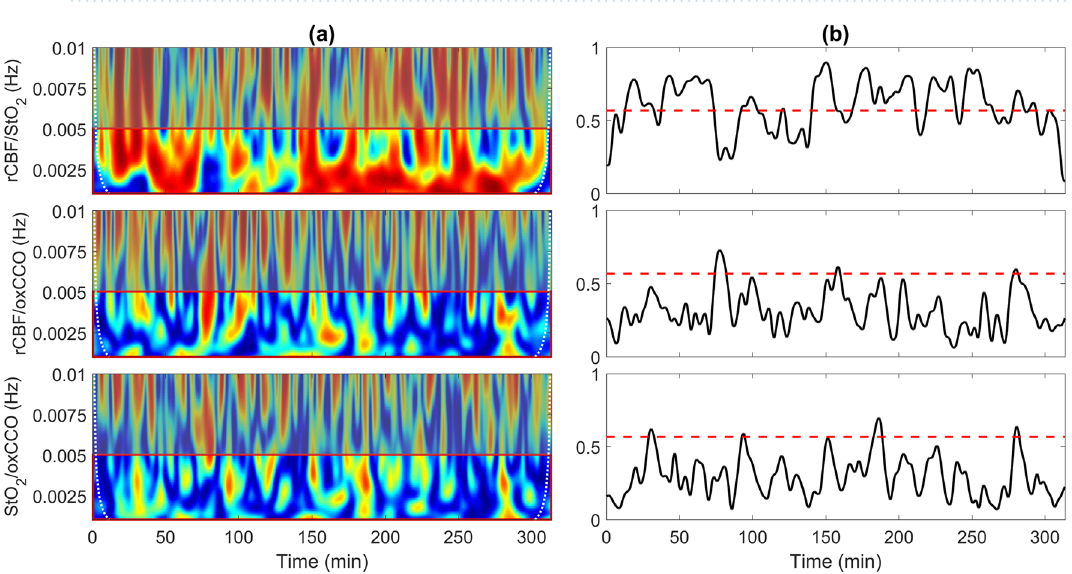
Figure 2. ( a ) Coherence between relative cerebral blood flow (rCBF) and tissue saturation (StO 2 ), rCBF and oxidation state of cytochrome c oxidase (oxCCO), and StO 2 and oxCCO for one patient on the first day of life. ( b ) Average coherence value in the frequency range 0.001 − 0.005 Hz [indicated by the red box in column ( a )]. The red dashed line indicates the statistical